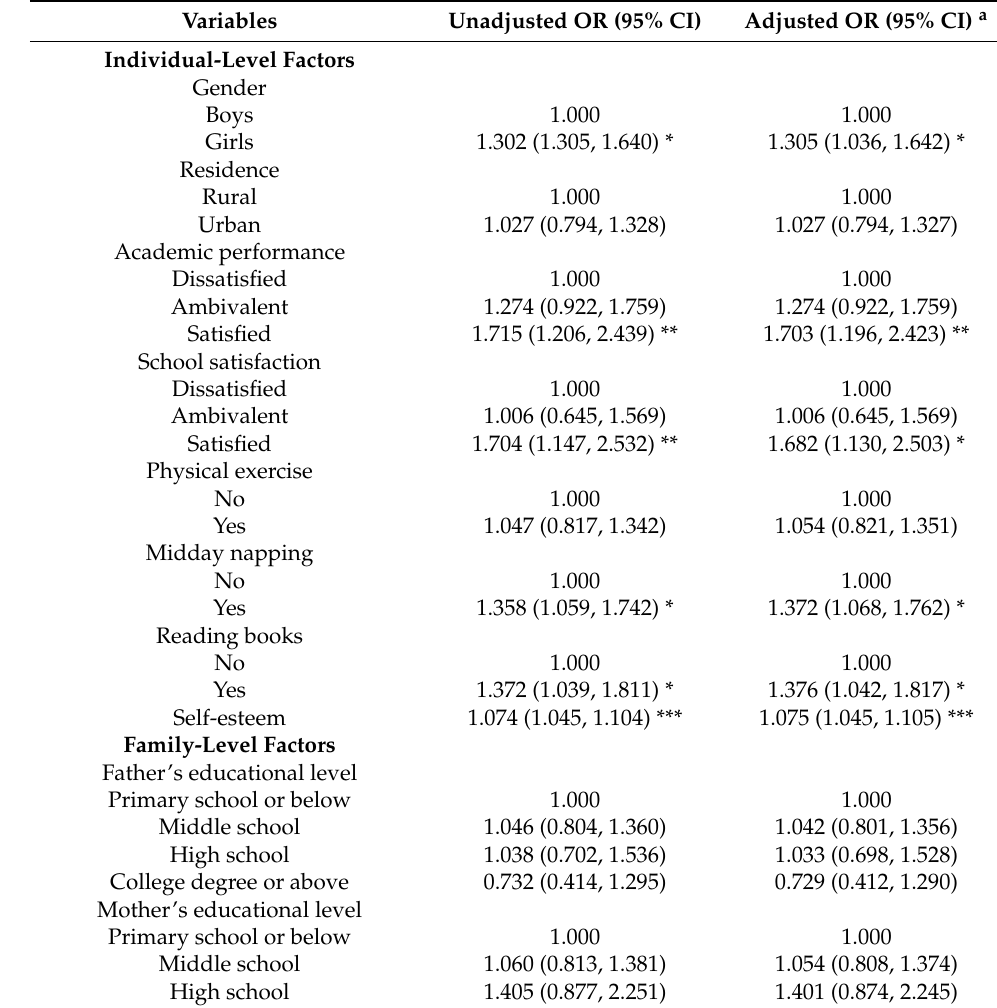
Table 3. Binary logistic regression analysis of factors associated with subjective well-being (SWB) among Chinese adolescents (N =